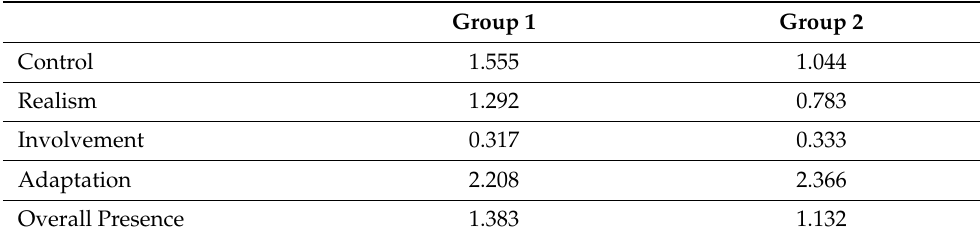
Table 7. Mean scores based on the presence questionnaire (scale from -3.0 to